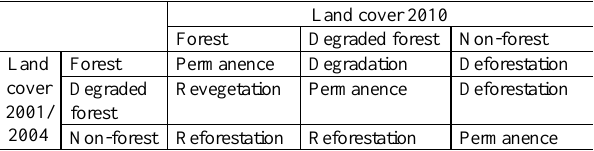
Table 3. Forest change for Monarch